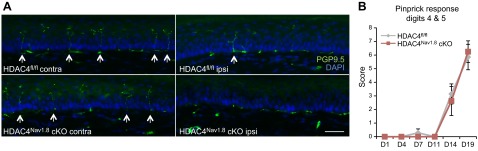
HDAC4 is not necessary for neuronal regeneration in vivo.
A) Six months after sciatic nerve crush, hind paw skin sections were stained with PGP9.5 to mark nerve fibers (green) and DAPI to visualize the epidermal border and assess skin reinnervation. Crossing fibers are indicated by arrows. Scale bar, 50 μm. B) Sensory recovery after sciatic nerve crush was measured by the pinprick test. No difference was observed between genotypes.